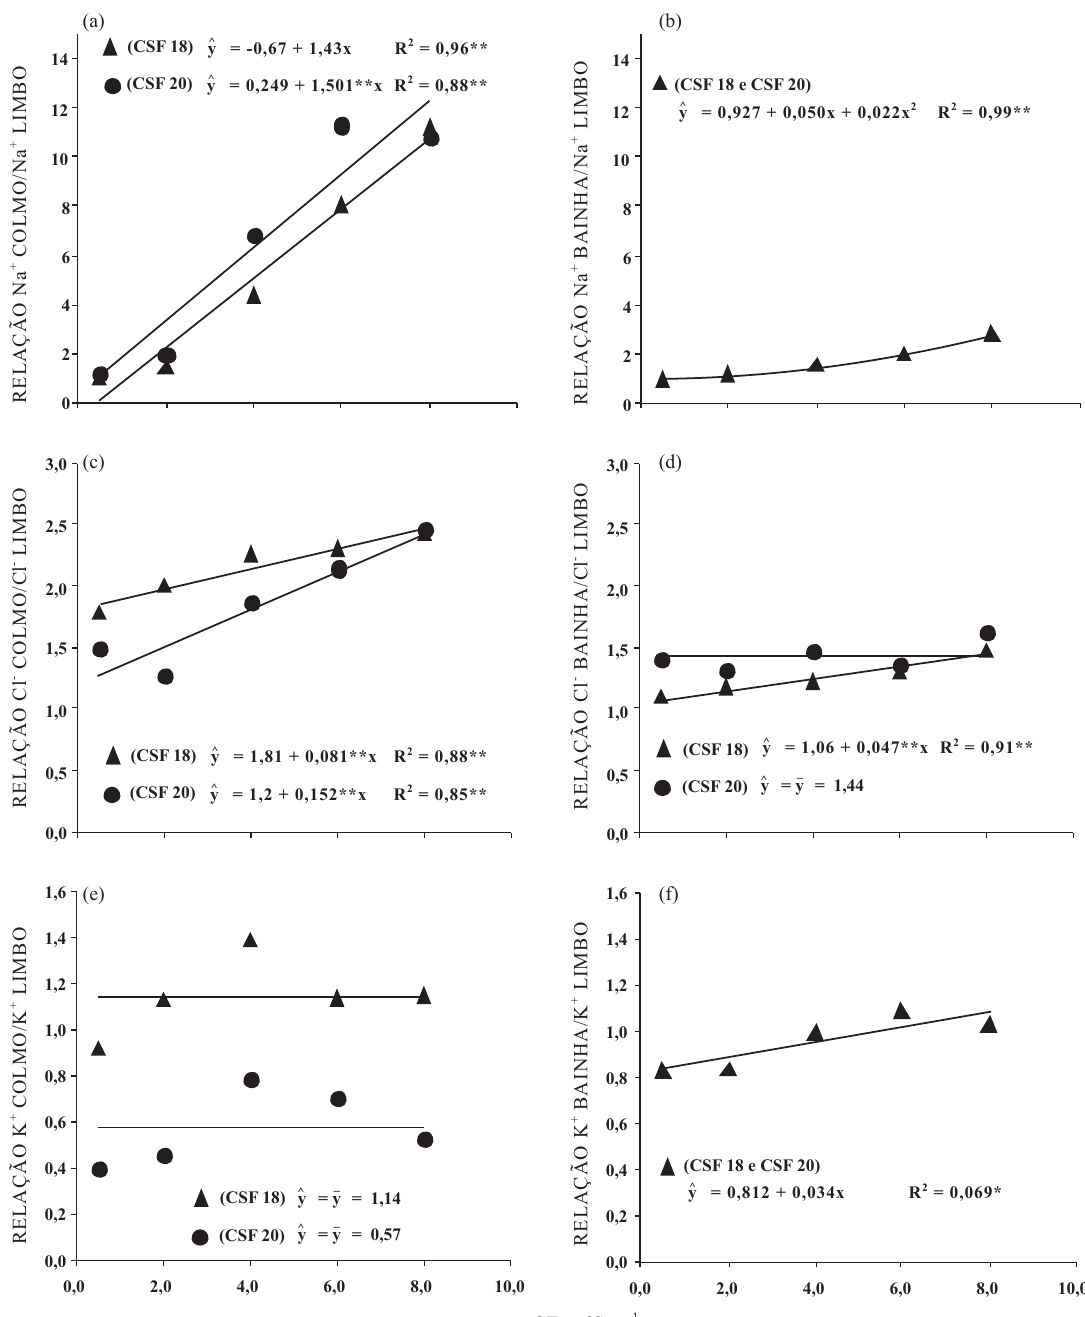
Figura 3. Relações entre os teores de Na + (a, b), Cl - (c, d) e K + (e, f) no colmo e bainha em relação aos respectivos teores desses íons no limbo foliar, em plantas de dois genótipos de sorgo forrageiro irrigadas com águas salinas com diferentes condutividades elétricas